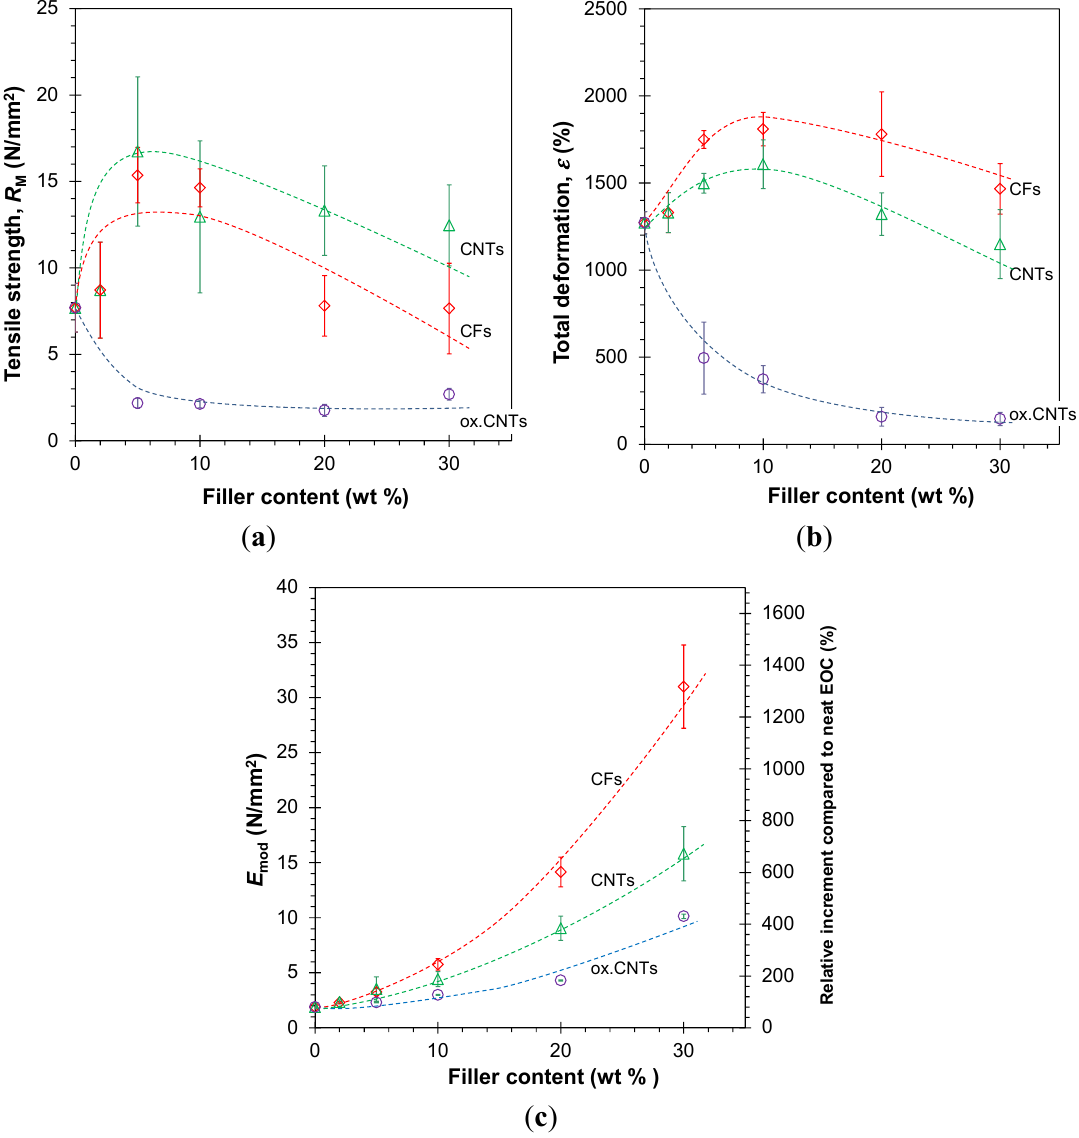
Figure 3. Tensile strength ( a ), maximum deformation ( b ), and Young’s modulus ( c ), as a function of the concentration of CNTs, oxidized CNTs, and CFs in the EOC-based composite membranes. The average Young’s modulus and its standard deviation were obtained from measurements of both strips (4–7 specimens) and square samples (2 specimens). The right axis ( c ) gives the relative increment compared to the neat polymer. Tensile strength and maximum deformation were based on strips only. Lines are plotted as a guide to the eye.